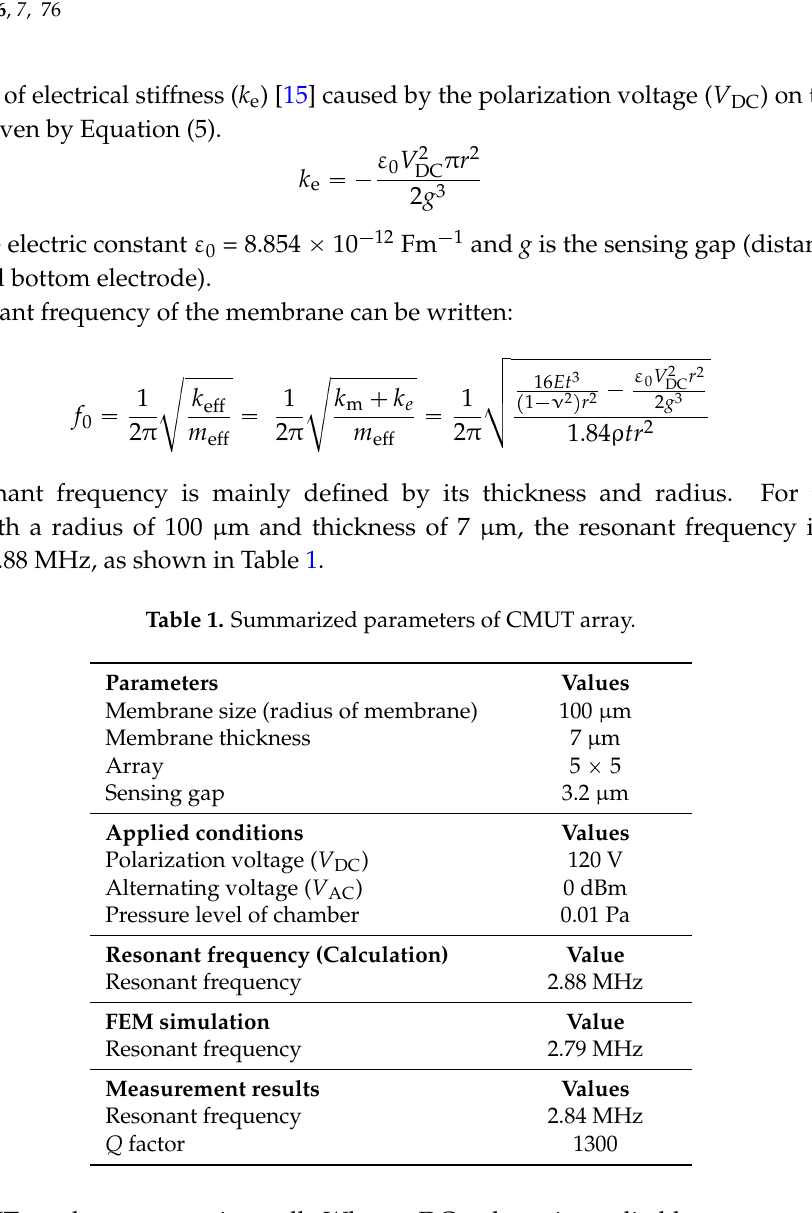
Figure 2. Electrical equivalent circuit model of CMUT